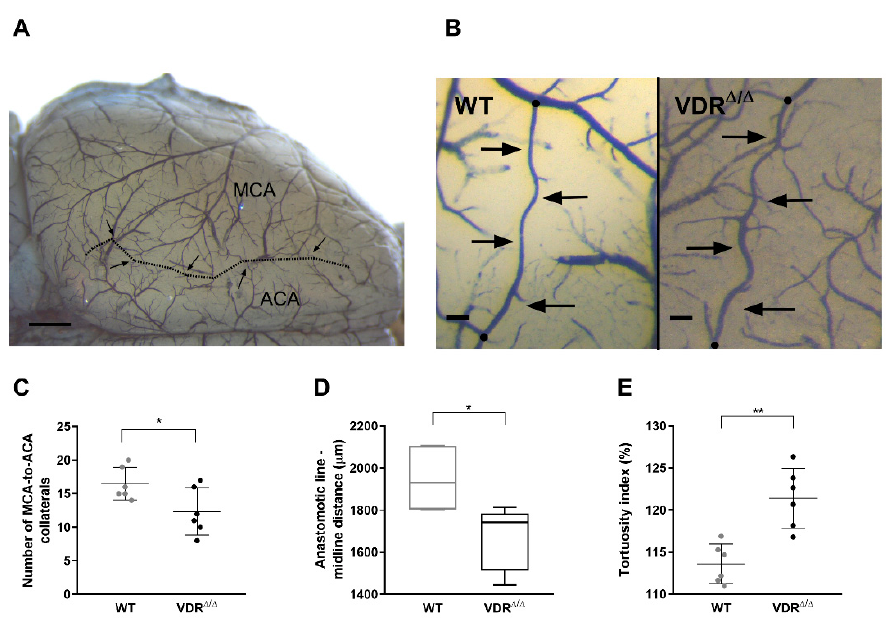
Figure 6. Evaluation of the morphology of intracranial collaterals. ( A ) Representative image of the dorsal surface of the brain infused with the mixture of black inks. The dotted line depicts the anastomotic line, whereas arrows denote the collaterals between the branches of the middle cerebral artery (MCA) and anterior cerebral artery (ACA). Scale bar represents 1000 μ m. ( B ) Representative images indicating the increased tortuosity of the collaterals of VDR Δ / Δ mice (right) as compared to WT mice (left). Arrows show the path of one MCA-to-ACA collateral, whereas black dots denote the end points of the collateral. Scale bars represent 100 μ m. ( C ) Functional inactivity of VDR decreased the number of MCA-to-ACA collaterals (* p < 0.05, n = 6 in both groups, Student’s unpaired t -test). ( D ) The anastomotic line was closer to the midline at 4 mm posterior from the frontal pole (level of bregma) in VDR Δ / Δ mice as compared to WT animals (* p < 0.05, n = 6, Mann–Whitney test). ( E ) The tortuosity index was increased in VDR Δ / Δ mice as compared to WT animals (** p < 0.001, n = 6, Student’s unpaired t -test). Normally distributed data are presented as scatter dot plots, whereas not normally distributed data are shown as box and whisker plots; n indicates the number of brains analyzed.